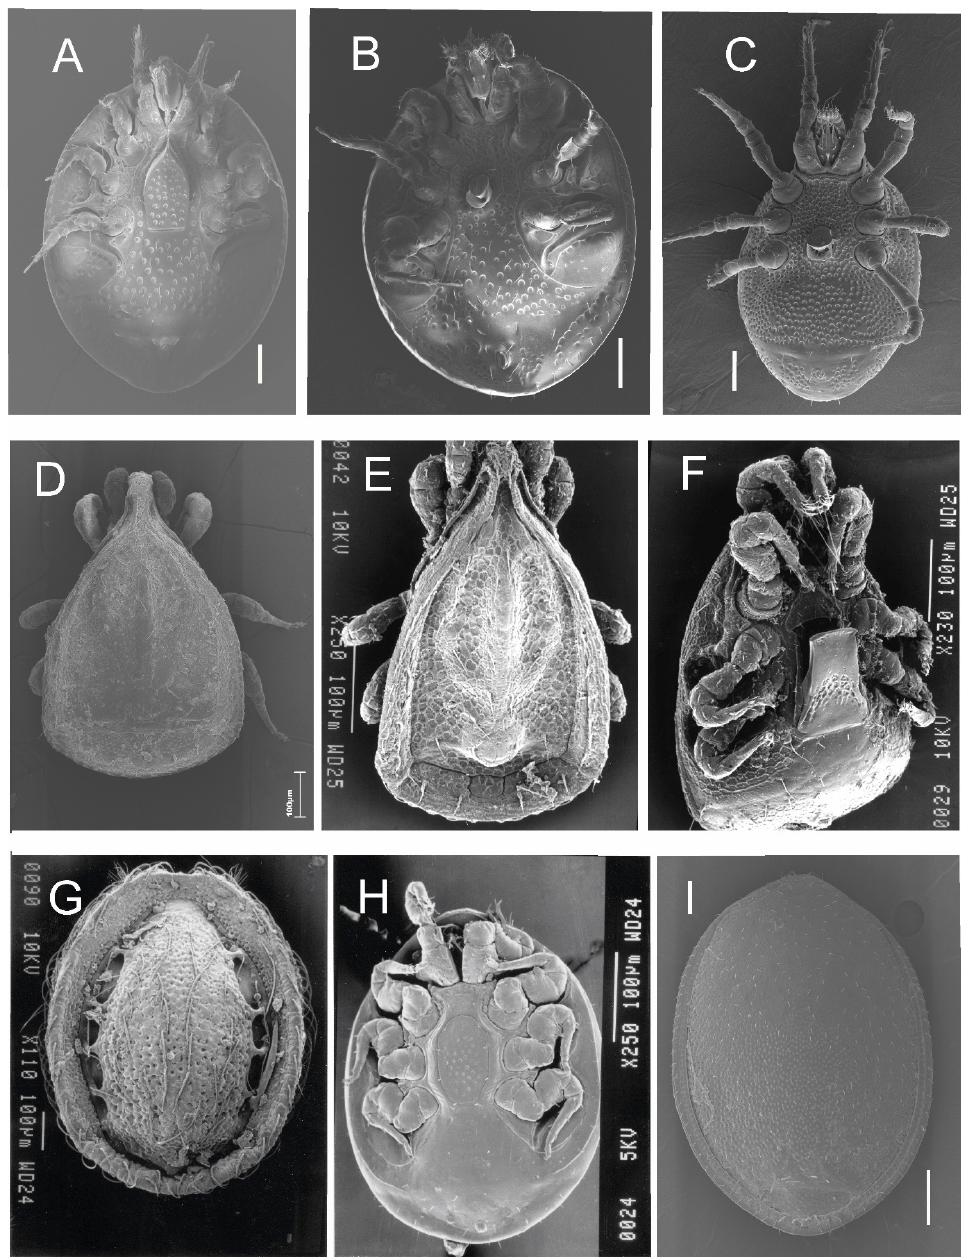
Figure A1. Species with different ranges in Poland: species occurring throughout the whole country— Oodinychus ovalis , female ( A ) and male ( B ) ventral side; Dinychus perforatus , male ventral side ( C ); species reaching the northern limit of its range in Poland— Trachytes irenae , female dorsal side ( D ); Trachytes minima —female ( E ) and male ( F ) dorsal side; a species with a boreal-mountain range— Neodiscopoma splendida , female dorsal side ( G ); species reaching the north-eastern limit of occurrence— Olodiscus misella , female ventral side ( H ); Carpathian endemic, migrating north along the Vistula River— Oodinychus obscurasimilis , female dorsal side ( I ).